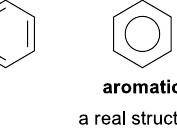
Table 1. Examples of aromatic stabilization energies (ASE) for benzene obtained experimentally and